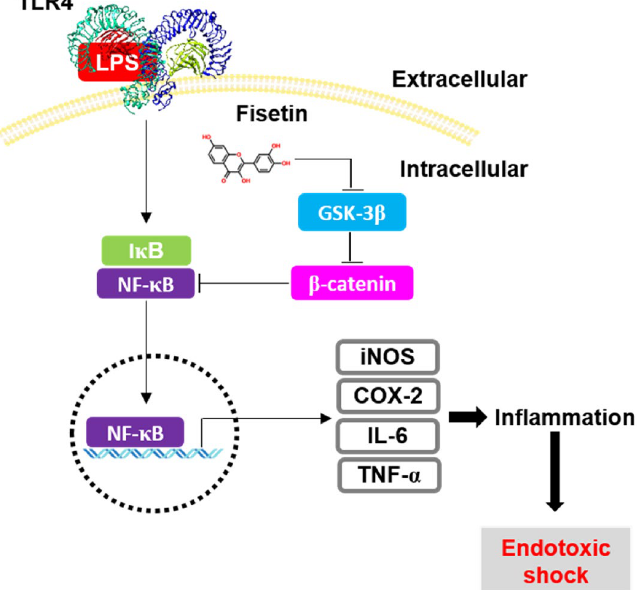
Figure 9. Fisetin inhibits GSK-3β-mediated NF-κB activation in the presence of β-catenin, leading to the inhibition of inflammation-induced septic shock. Once macrophages are exposed to high concentrations of the bacterial endotoxin, LPS, they initiate an inflammatory response and endotoxic shock by upregulating the expression of NF-κB-induced inflammatory genes, such as iNOS, COX-2, IL-12, IL-6, and TNF-α . Fisetin binds to the noncompetitive ATP-binding sites of GSK-3β and phosphorylates GSK-3β at Ser9, resulting in the inactivation GSK-3β and release of β-catenin from the destruction complex. The released β-catenin inhibits the transcriptional activity of NF-κB, thereby alleviating LPS-induced inflammation and endotoxic